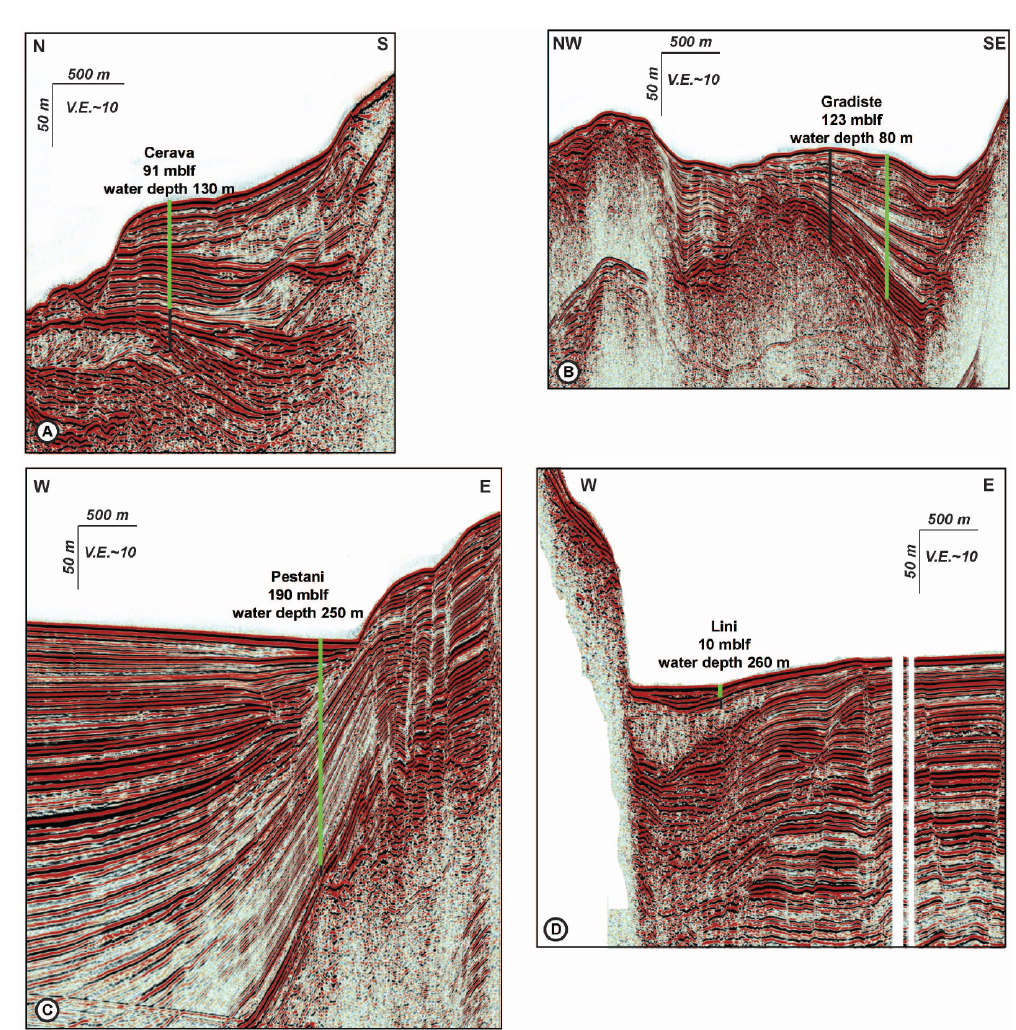
Figure 4. Seismic cross sections at drill sites (A) Cerava, (B) Gradište, (C) Peštani, and (D) Lini. The green line in the individual seismic profiles indicates the approximate maximum depth of cores recovered, whilst the black line indicates the target